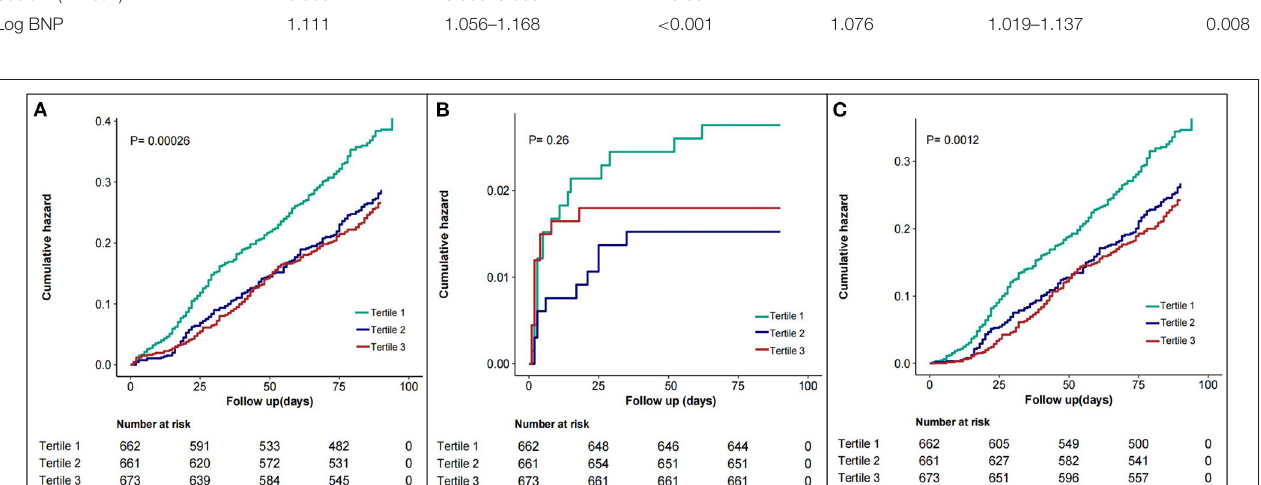
FIGURE 3 | Kaplan–Meier estimates of 3 months outcomes according to serum chloride level. (A) for the composite endpoint event, (B) for all-cause death, (C) for all-cause rehospitalization. Chloride tertile1 is 70.9–100 mmol/L, tertile 2 is 100.1–104.7 mmol/L, and tertile 3 is 104.8–125.1 mmol/L.